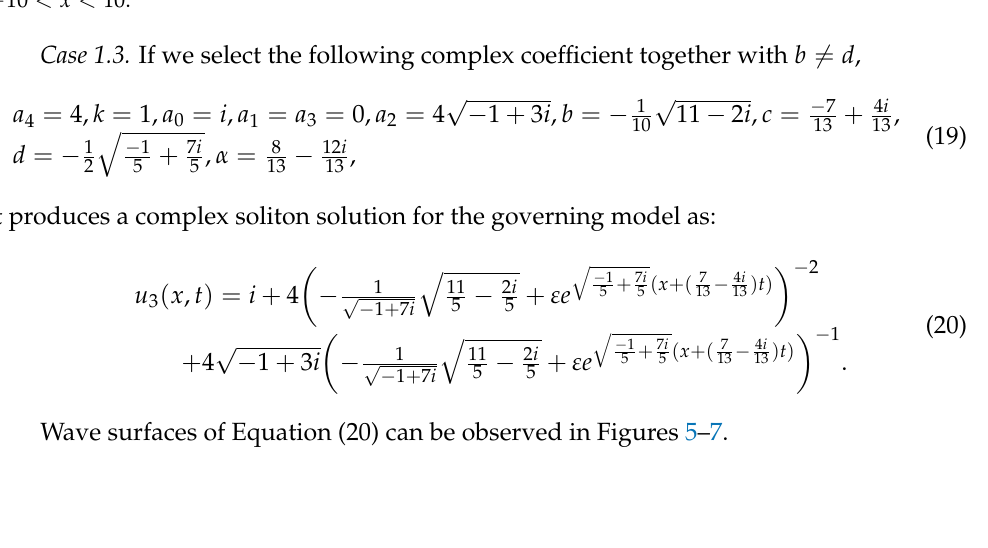
Figure 4. 2D graph of Equation (18) for α = 0.2, b = 0.3, c = − 0.5, ε = 0.4, d = 0.1, t =